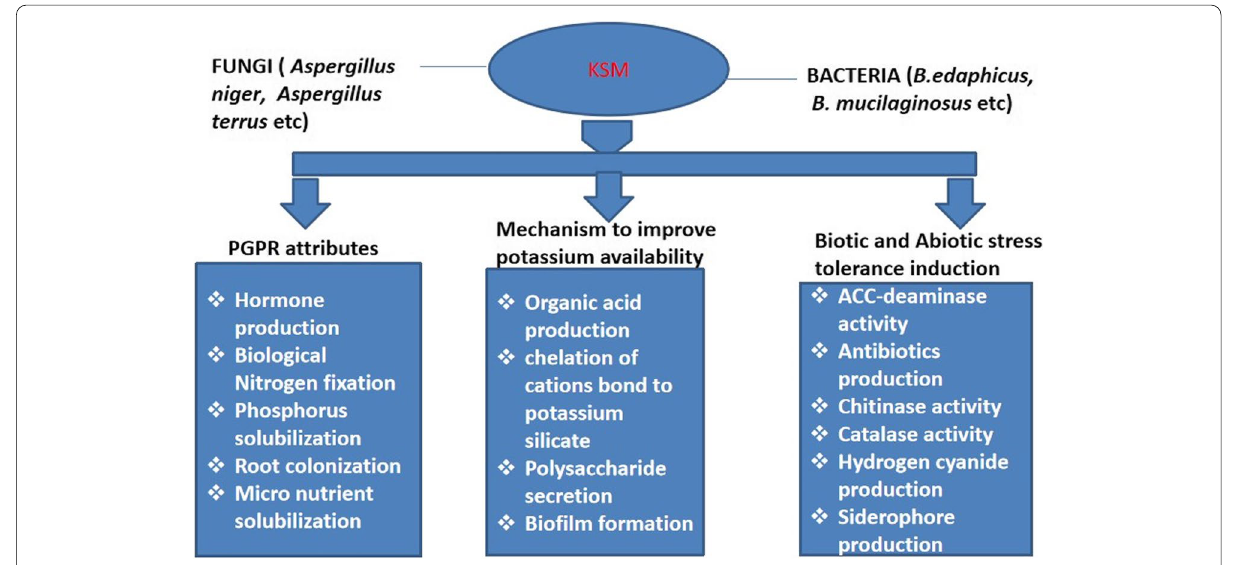
Fig. 3 Benefits and mechanisms of action of potassium solubilizing